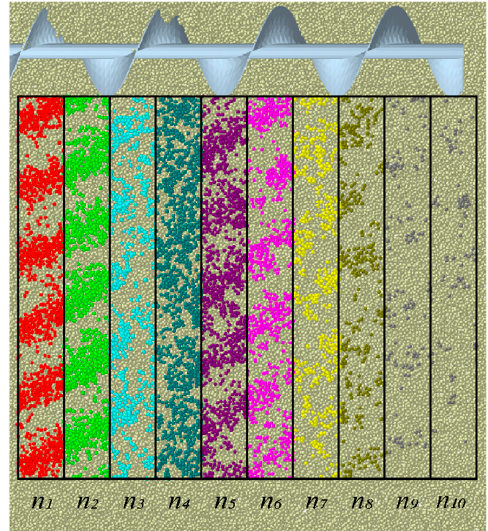
Figure 7. Evaluation index of soil uniformity.